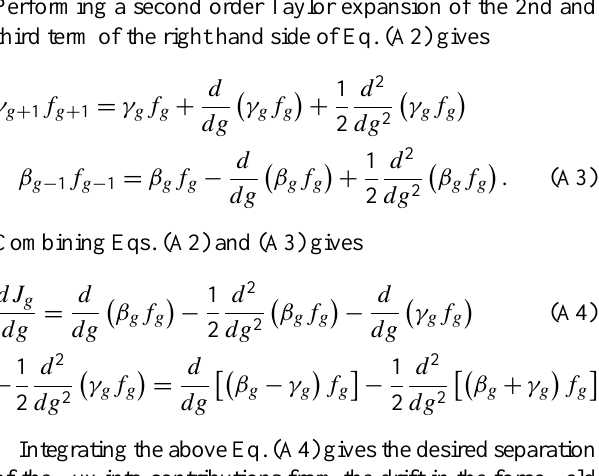
Figure A1. An example of steady state cluster size distribution at Sub-Kelvin size range derived 8 Fig. A1. An example of steady state cluster size distribution at sub- using parameters from Table 1. 9 Kelvin size range derived using parameters from Table